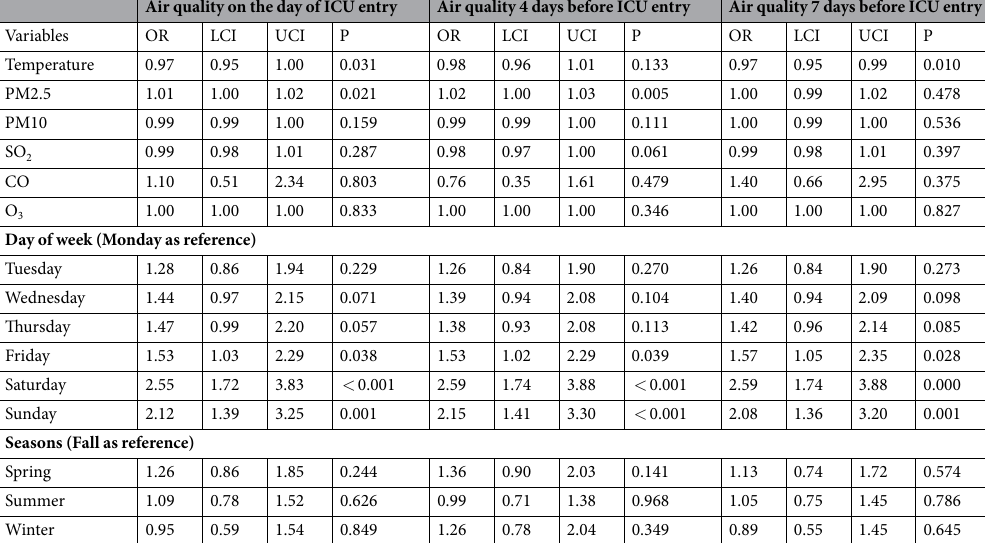
Table 2. multivariable regression model investigating independent predictors of ICU admission due to pneumonia. Abbreviations: PM: particulate matter; SO 2 : sulfur dioxide; CO: carbon monoxide; NO 2 : nitrogen dioxide; O 3 : ozone; LCI: lower limit of 95% confidence interval; UCI: lower upper of 95% confidence interval; OR: odds ratio.